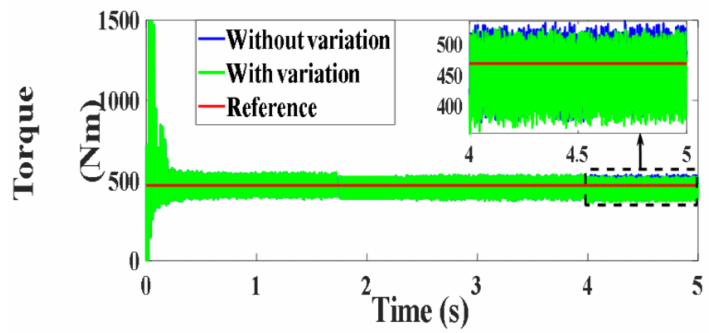
Figure 129. Developed torque under PVC (Nm).